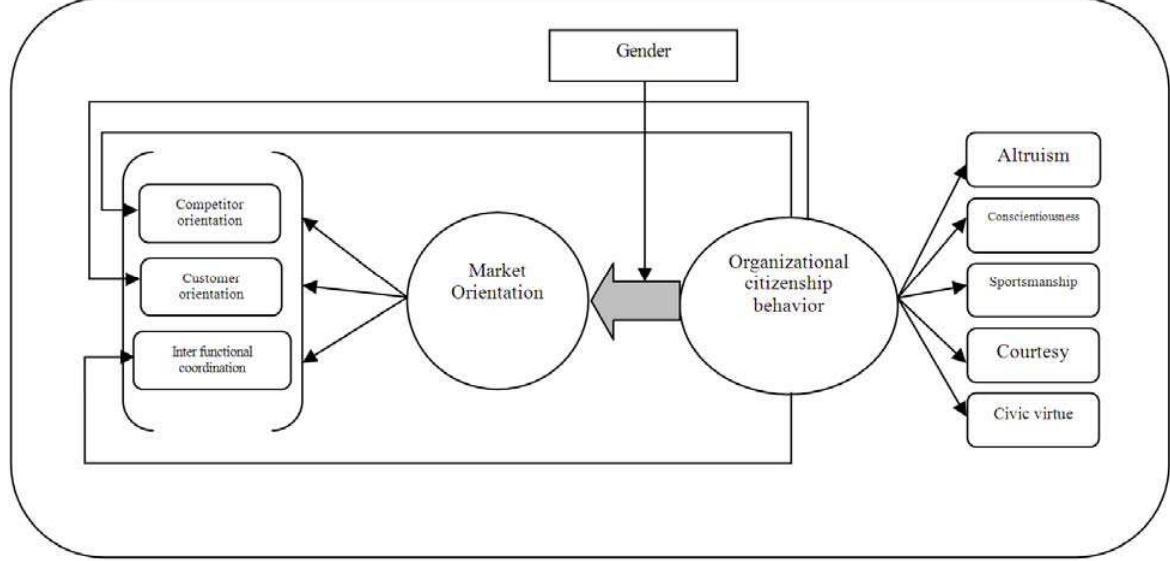
Fig. 1. Research conceptual